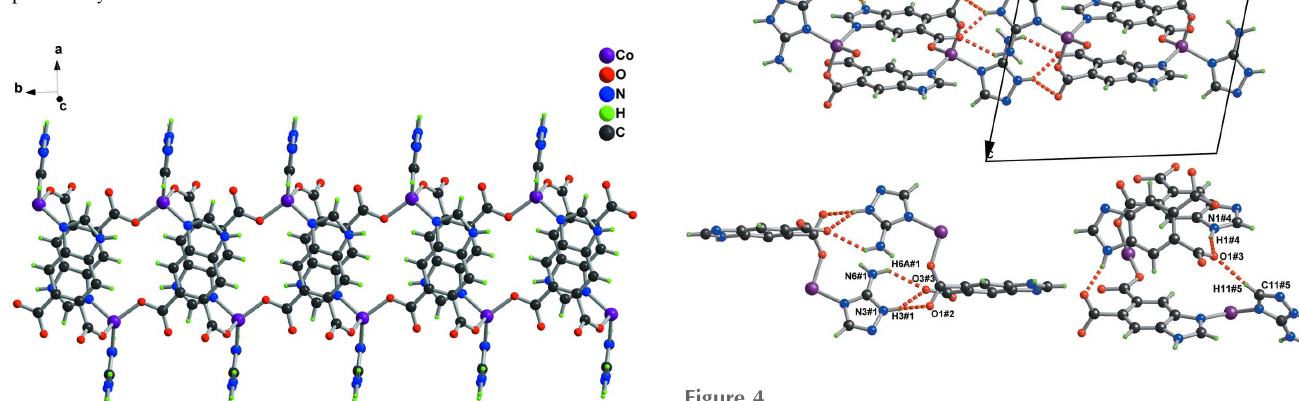
Figure 4 A view of the hydrogen bonds in the title coordination